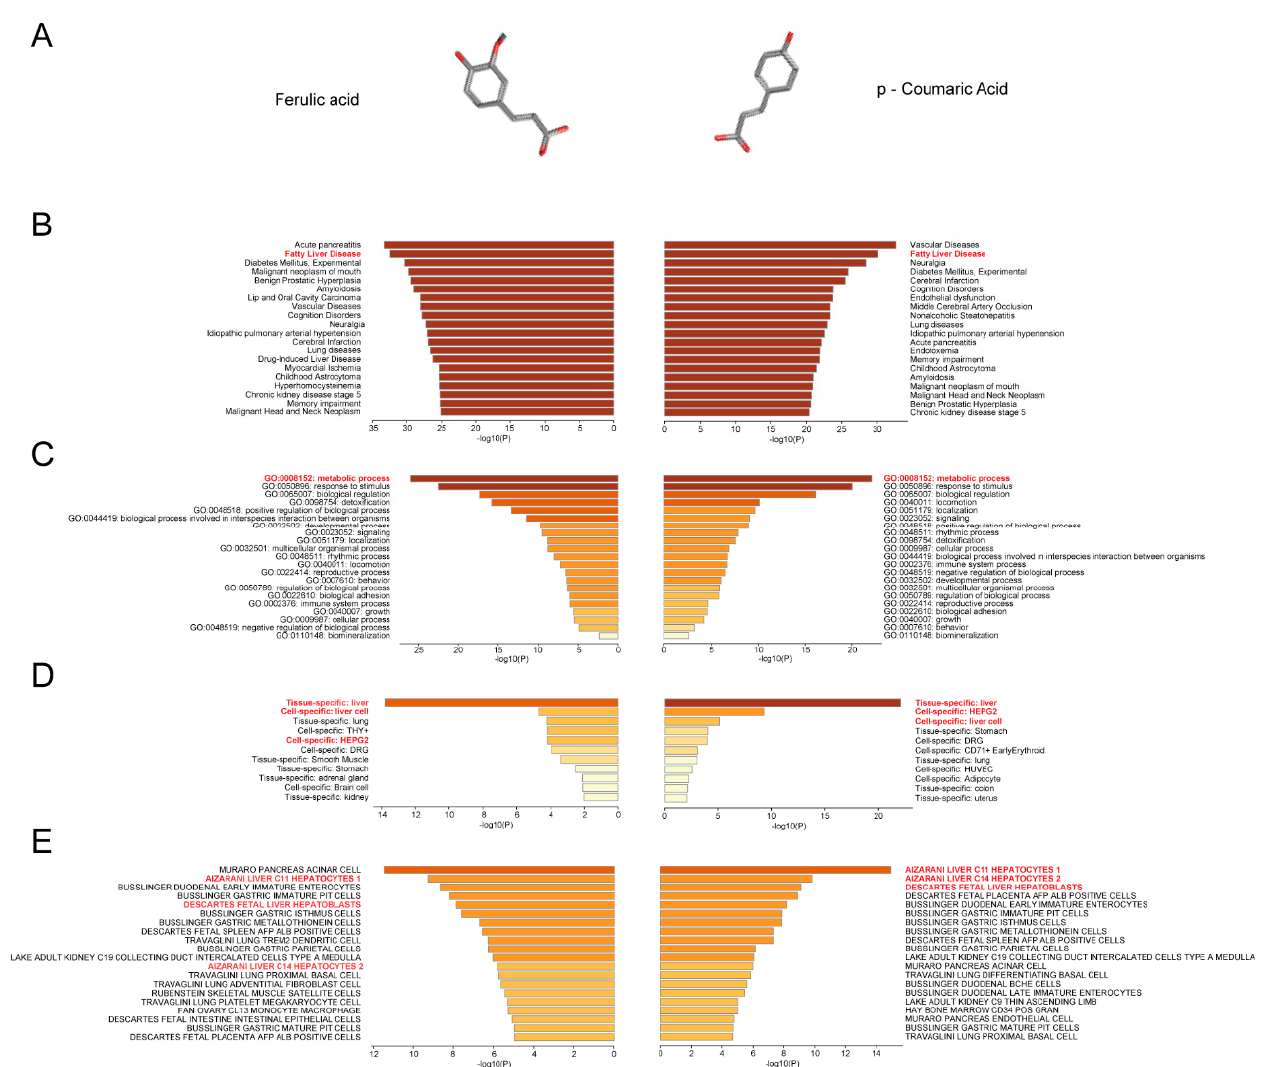
Figure 1. Prediction of the association of FA/p-CA with non-alcoholic fatty liver disease. ( A ) Chem-ical structure of FA and p-CA. FA and p-CA target genes were imported into the database. ( B – E ) Summary of enrichment analysis in DisGeNET ( B ). The top-level gene ontology biological processes ( C ). Summary of enrichment analysis in PaGenBase ( D ) and Cell Type Signatures ( E ). Colored by p -values, the color becomes lighter as the p -value increases.